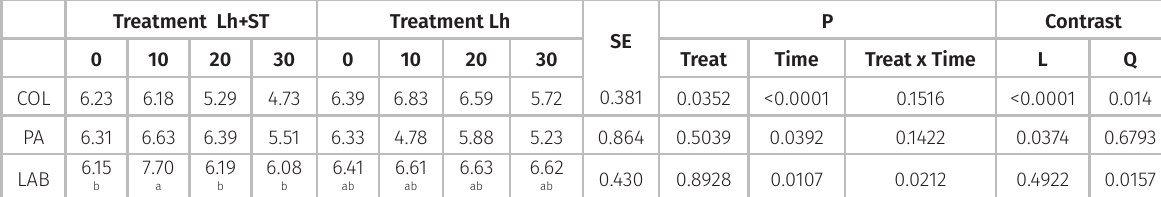
Table V. Parameters of microbiological quality of ripened cheese. Treatment Lh+ST Treatment Lh